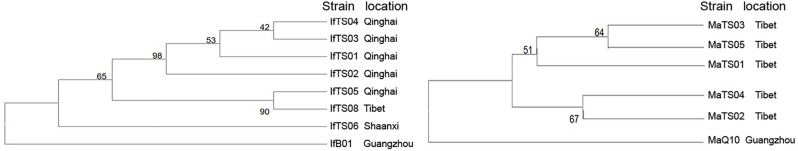
Phylogenetic trees of I. fumosorosea and M. anisopliae var. anisopliae strains based on the rDNA-ITS sequences.Bootstrap values are based on is 1,000 replicates. Numbers shown above branches are bootstrap percentages for clades supported above the 50% level.